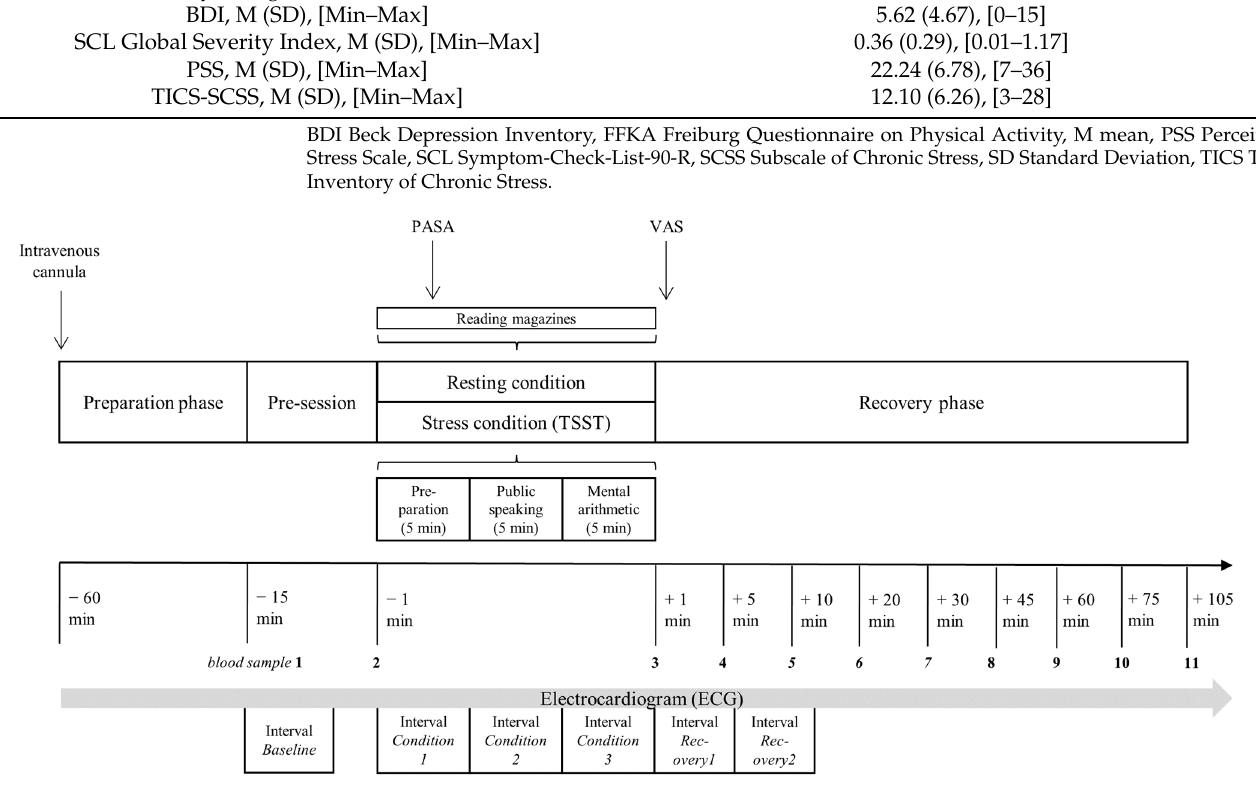
Figure 2. Overview of the examination procedure. PASA Primary Appraisal Secondary Appraisal, TSST Trier Social Stress Test, VAS Visual Analogue Scale.